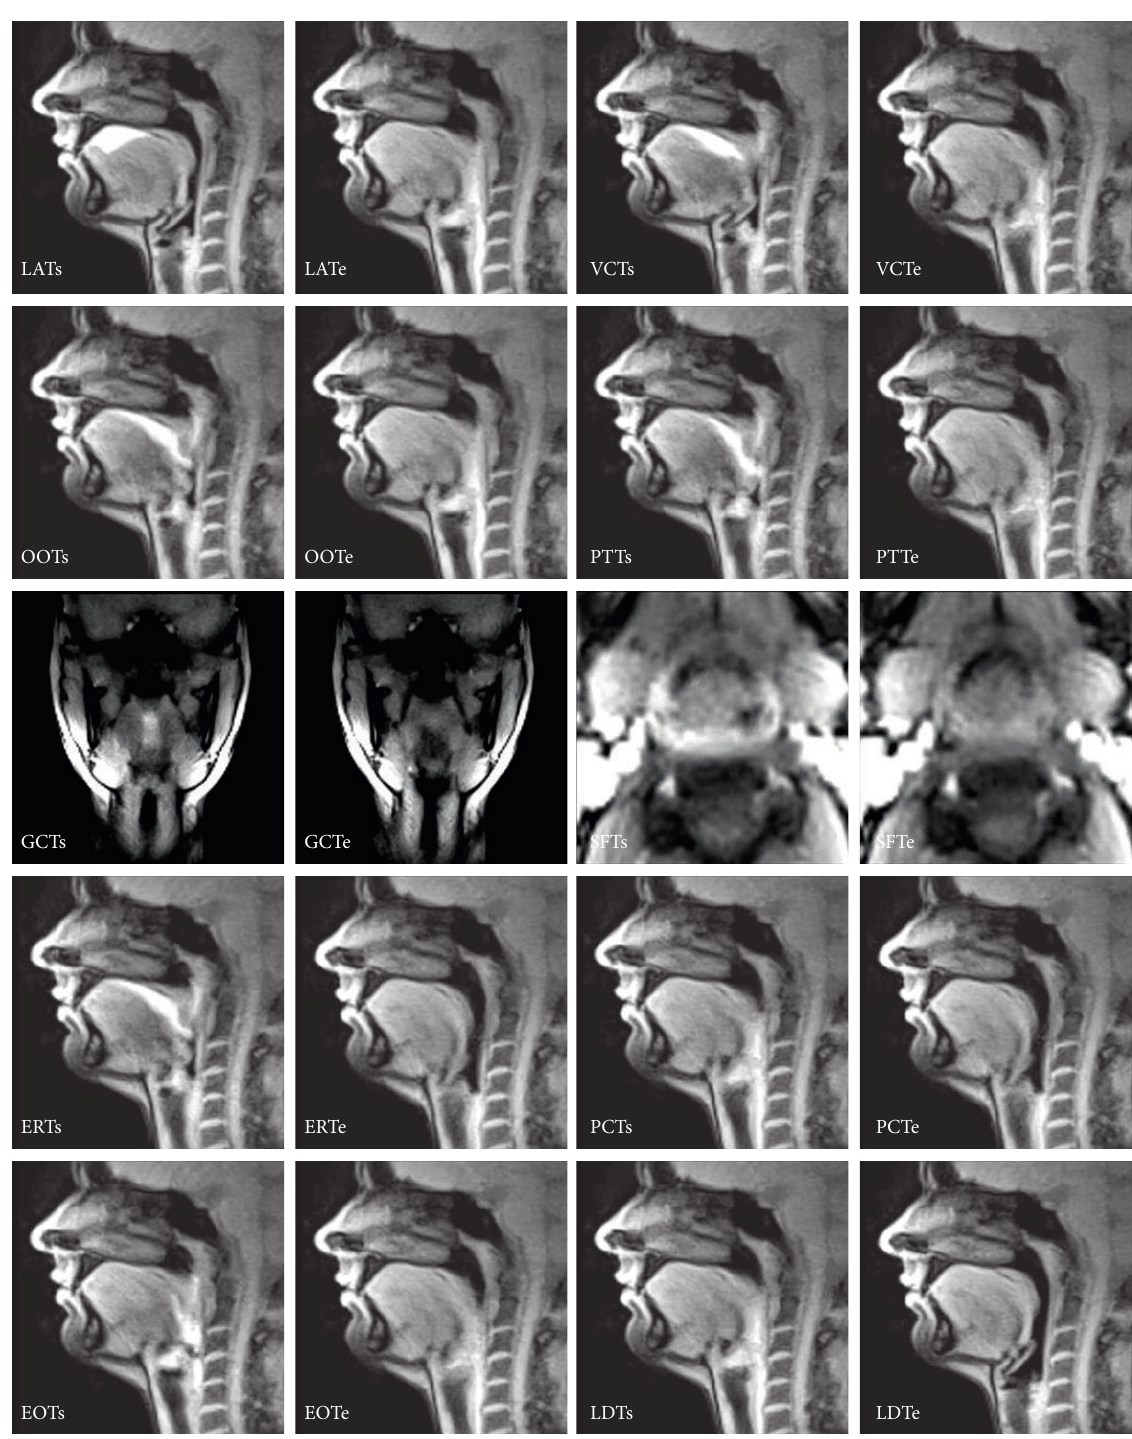
Figure 1: Physiological events of normal swallowing as seen by real-time MRI (27-year-old female). LAT: laryngeal ascent, VCT: velo- pharyngeal closure, OOT: oro-velar opening (start time defined as reference), PTT: pharyngeal transit, GCT: glottal closure, SFT: vallecular and piriform sinus filling, ERT: epiglottic retroflexion, PCT: pharyngeal constriction, EOT: esophageal opening, LDT: laryngeal descent (“s” and “e” refer to respective start and end times). The images are selected from respective movies (see Supplementary Movie 1 in the Supplementary Material available online at http://dx.doi.org/10.1155/2014/493174) at a resolution of 41.2 ms (24.3 frames per second) and sorted according to their temporal onset from top left to bottom right. For further details see